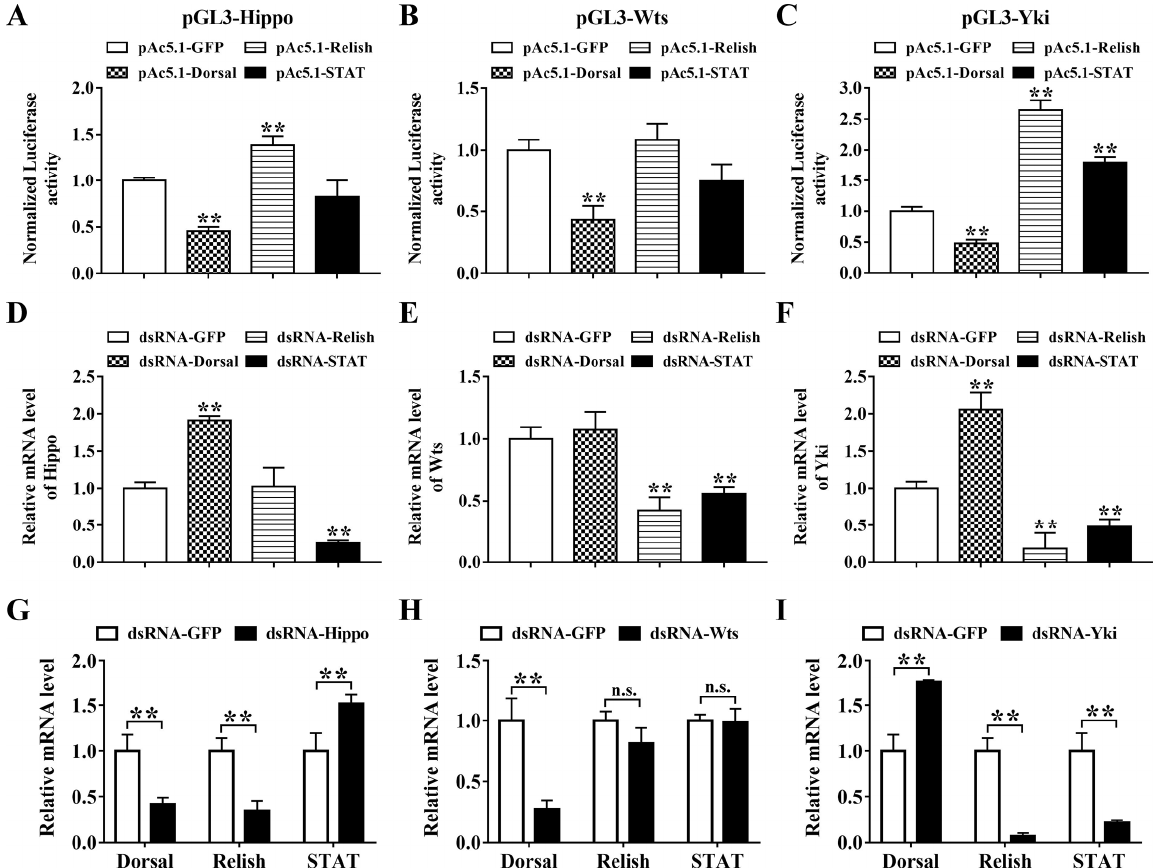
Figure 3. Regulatory relationship between Hippo signaling components and NF- κ B/STAT. Regula- tory effects of Relish, Dorsal, and STAT on the promoters of Hippo ( A ), Wts ( B ), and Yki ( C ) were examined by dual-luciferase reporter assay. The mRNA levels of Hippo ( D ), Wts ( E ), and Yki ( F ) in Dorsal-, Relish-, and STAT-silenced shrimp and those of Dorsal, Relish, and STAT in Hippo- ( G ), Wts- ( H ), and Yki-silenced ( I ) shrimp were investigated by qPCR. The gene knockdown efficiencies in vivo are shown in Figure S2. ** p < 0.01 and n.s. p > 0.05 by two-tailed unpaired Student’s t -test.